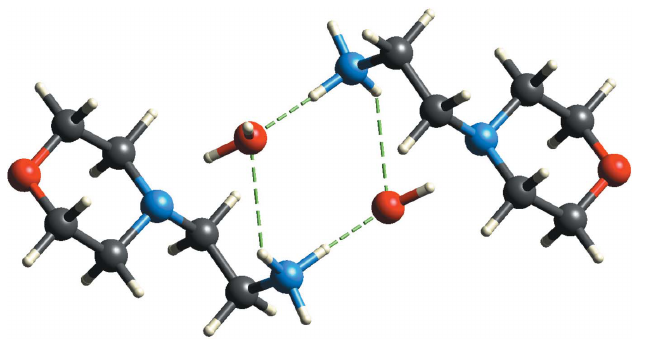
Figure 4 R 2 (8) ring motif formed between ammonium group and water molecules. 4